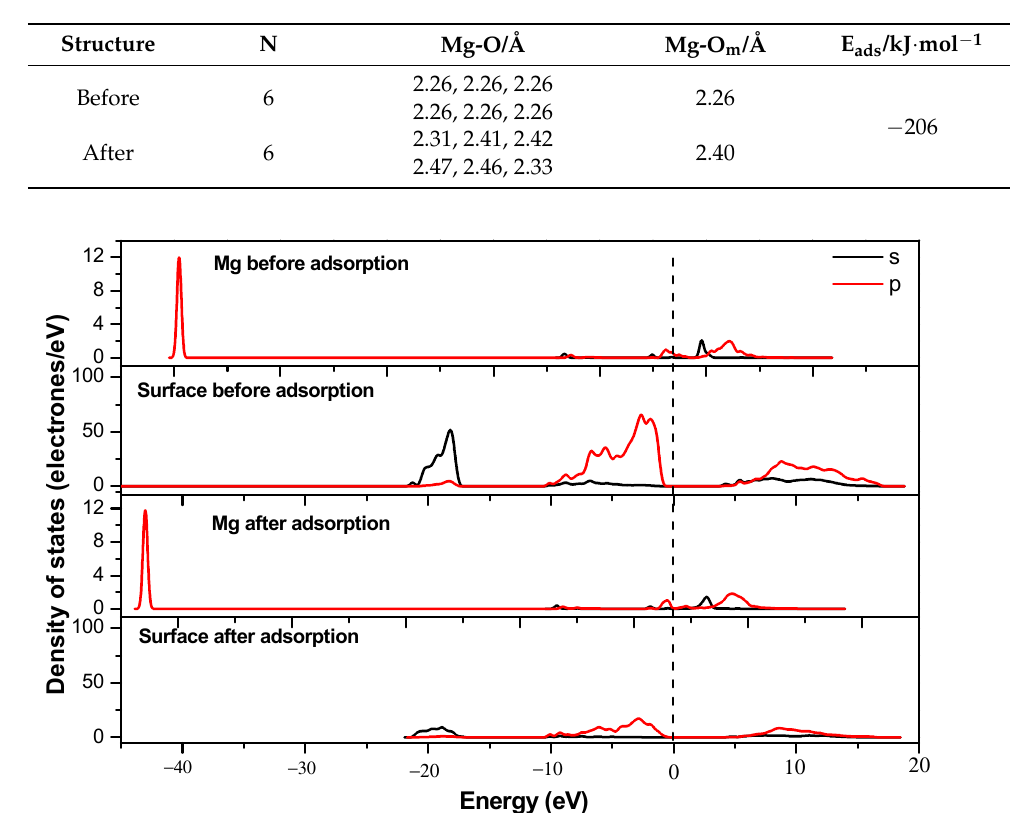
Figure 6. PDOS of Mg and (001) surface of Mt before and after adsorption. Table 6. Mulliken charges of Mg adsorbed on the (001) surface of Mt.